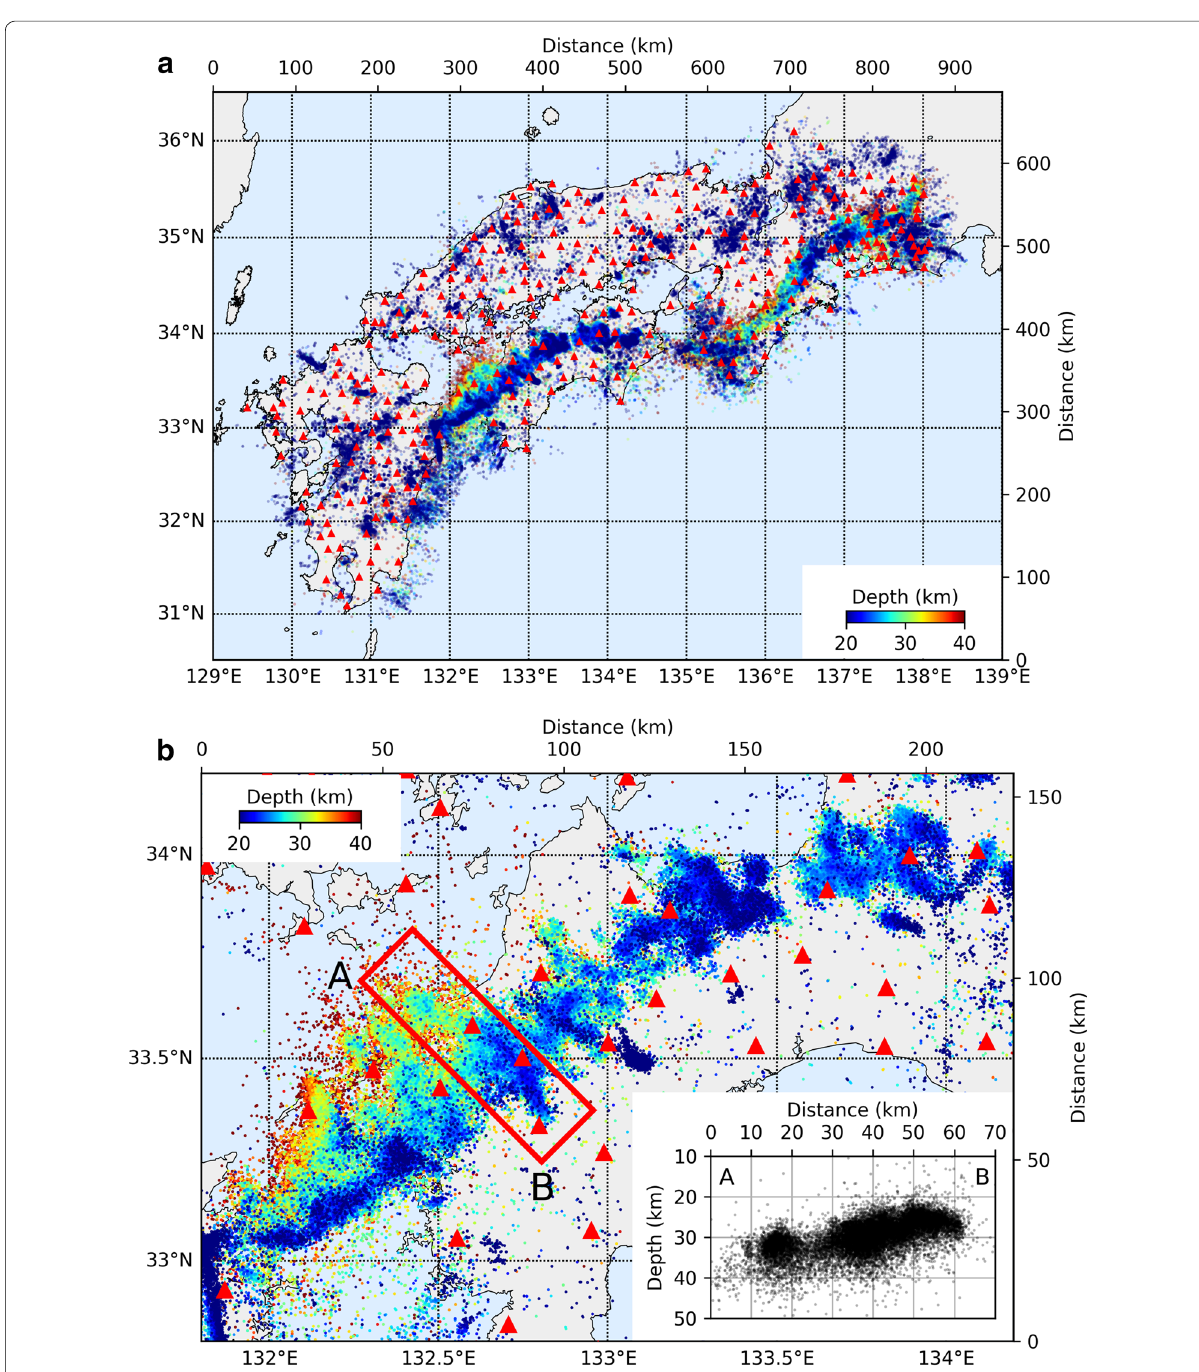
Fig. 8 Detected event distribution without the second criterion of outlier control which rejects an envelope when the cross-correlation with the template is below the threshold, C t lim , for a western Japan and b western Shikoku. The dots show the located tremor hypocenters, with the colors indicating their depths. Many of scattered hypocenters are considered as false detections. The red triangles show the Hi-net seismic stations. The inset figure in b shows a cross section of tremors located within the red